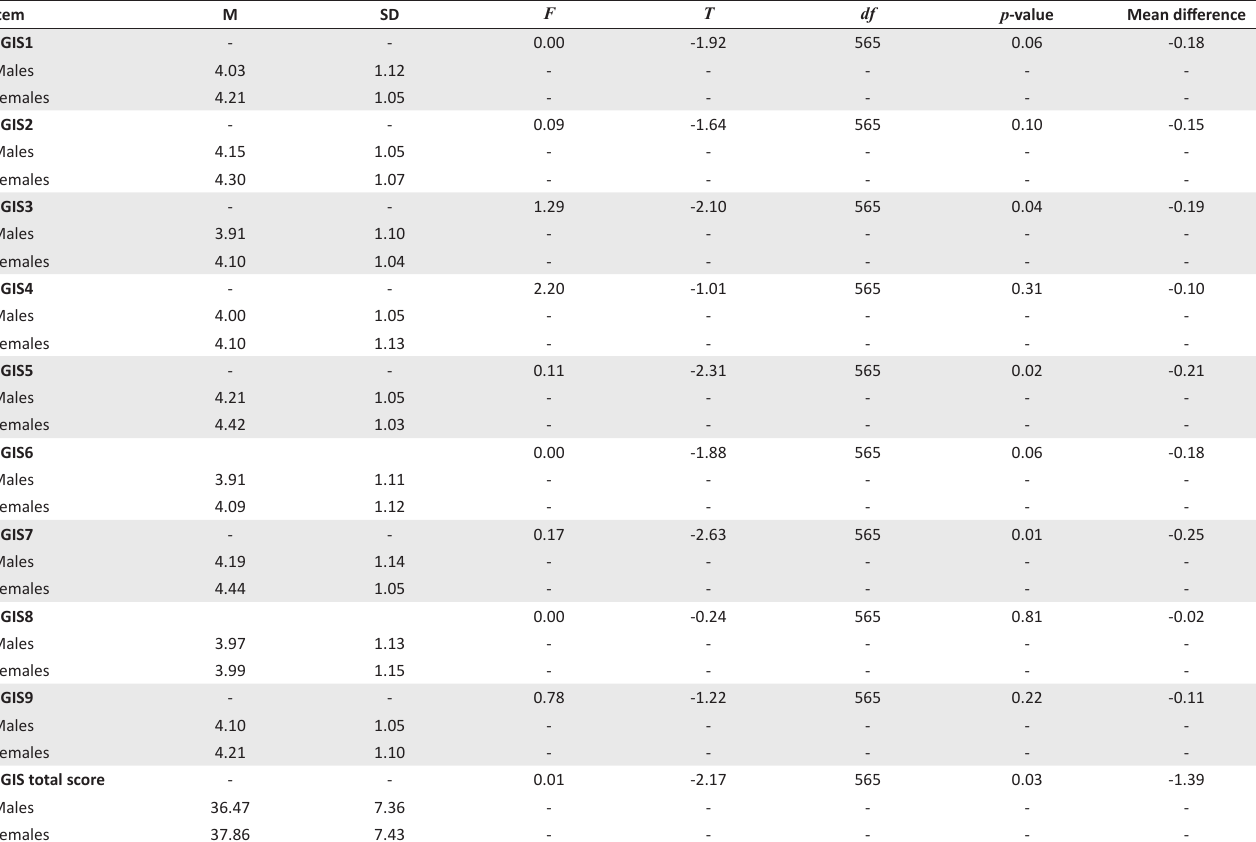
TABLE 2: Independent t -test results for the PGIS items for the I-O Psychology students between males ( n = 214) and females ( n = 353). Item M SD F PGIS1